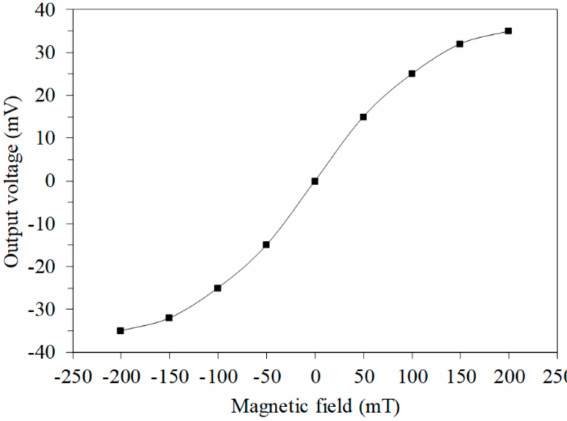
Figure 3. Simulated output voltage (OV) in the y -axis magnetic field.